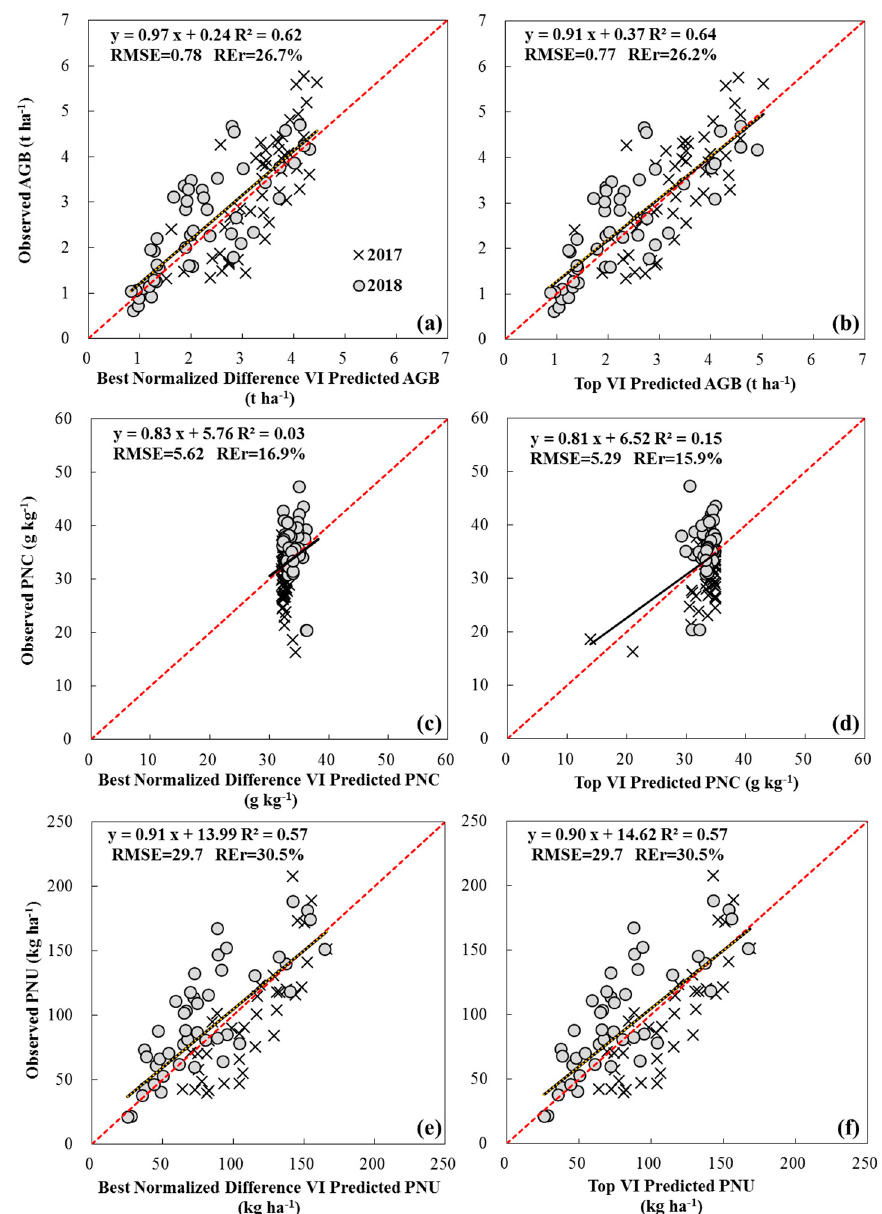
Figure 3. Validation results for the prediction of aboveground biomass (AGB), plant nitrogen concentration (PNC), and plant nitrogen uptake (PNU) using the optimal estimation model of normalized di ff erence VIs (NDVI in a ; GNDVI in c ; NDRE in e ) and the top VIs (NNIRI in b ; MCCCI in d ; REVI opt in f ) across varieties and years, respectively. Black lines indicate the regression line, and red dotted lines indicate the 1:1 lines.